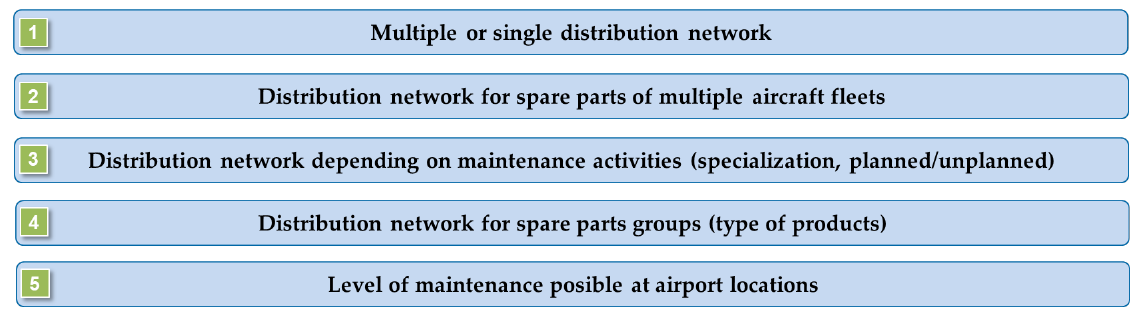
Figure 12. Decision-making influenced by the methodology of the research study (own elaboration).